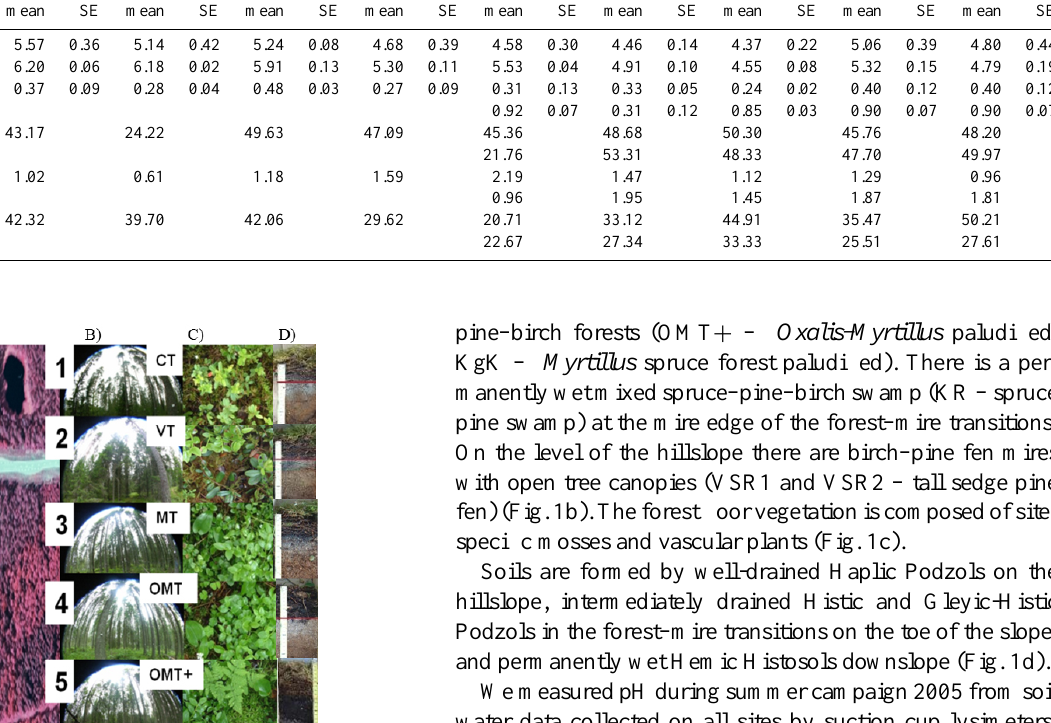
Table 1. Site soil water solution pH and soil properties. CT VT